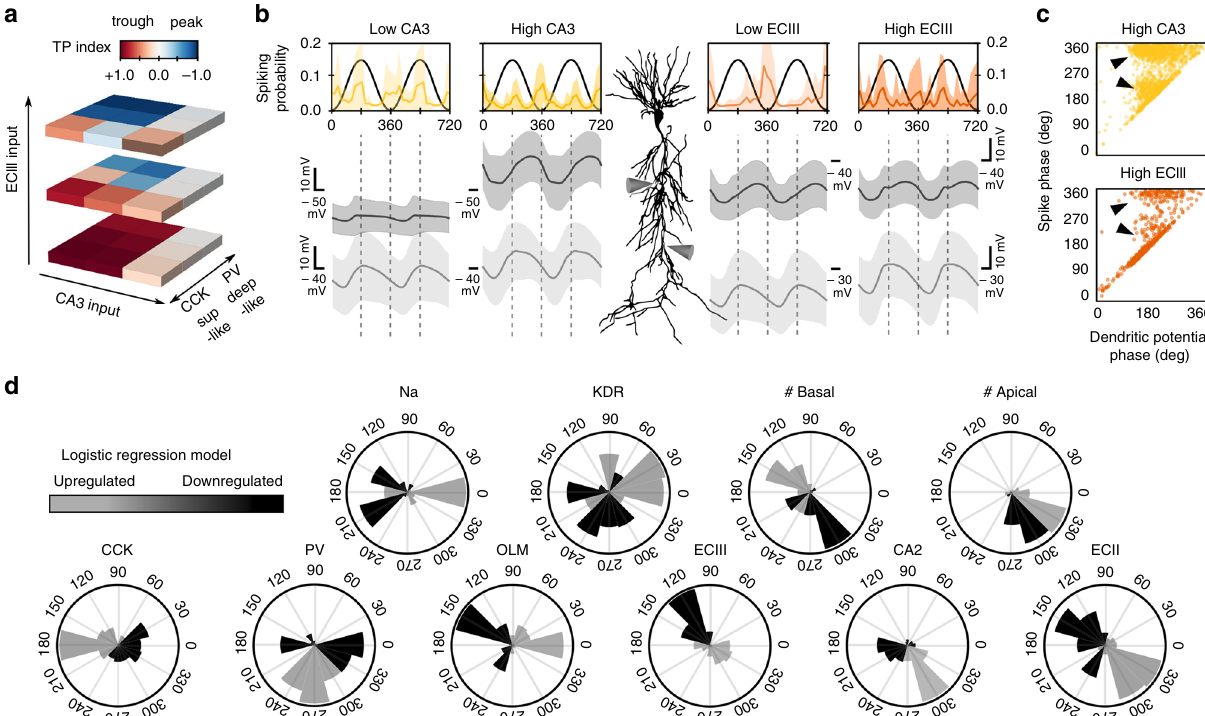
Fig. 4 Effect of glutamatergic input pathways. a Effect of CA3 and ECIII input pathways on phase preference of synthetic cells across the PV/CCK axis. b Mean phase-locked fi ring histograms and membrane potential dynamics at the proximal and apical dendritic trunk from all synthetic cells examined under low and high levels of activity of the CA3 (yellow) and ECIII inputs (orange). Data from 48 synthetic cells in each condition (1000 theta cycles each). c Relationship between the fi ring phase and the phase of the maximal dendritic depolarization measured at the proximal apical trunk. Each dot represents data from one spike from 48 synthetic cells in the high CA3 and high ECIII conditions. Arrowheads indicate uncorrelated phase-locking dynamics between fi ring and dendritic potentials. Bimodality was stronger during higher CA3 inputs. Data from 1000 theta cycles in each condition. d Results of a multinomial logistic regression model suggest phase-speci fi c contribution of different individual factors. Black, upregulation. Gray, downregulation. Data from 731 heterogeneous synthetic cells and >300,000 theta cycles. See Supplementary Fig.